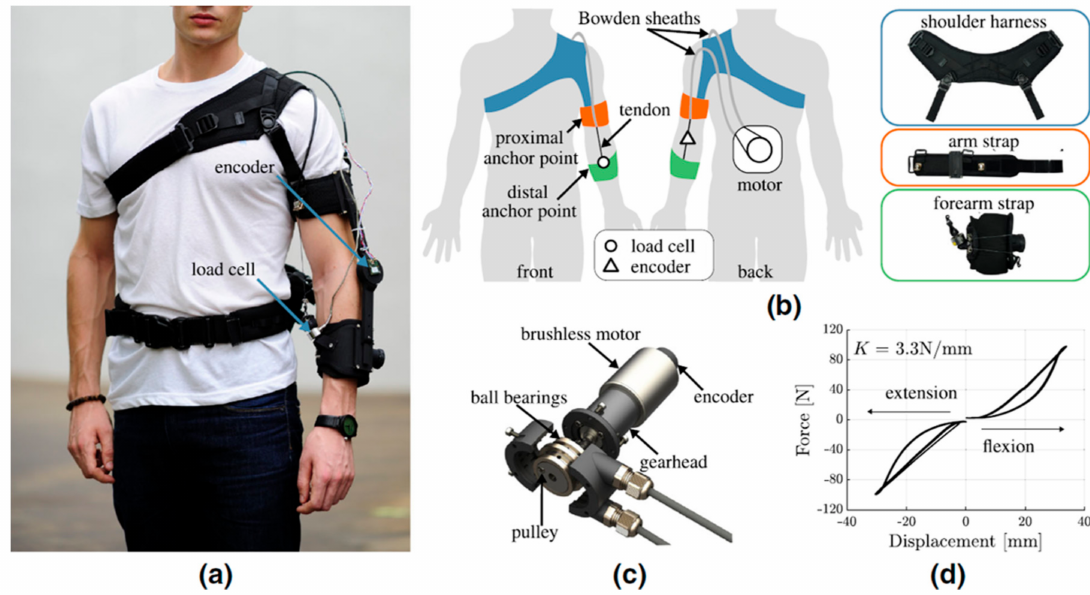
Figure 3. Components of the exosuit used to reduce elbow effort. ( a ) The exosuit consists of three straps that wrap around the shoulder and has an encoder and a load cell. ( b ) It also has a motor, anchor points, and Bowden cables. ( c ) In the transmission of force, the brushless motor is used together with gearhead, pulley, ball bearings. ( d ) Stiffness of the exosuit [57] (Open